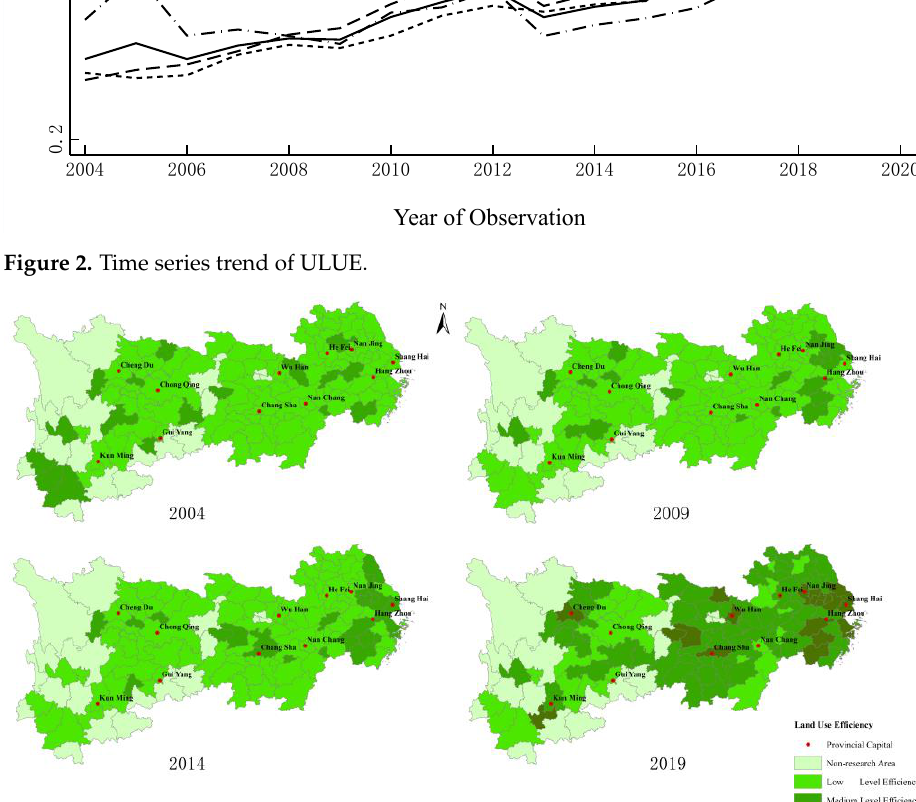
Figure 3. Spatial-temporal distribution of ULUE.